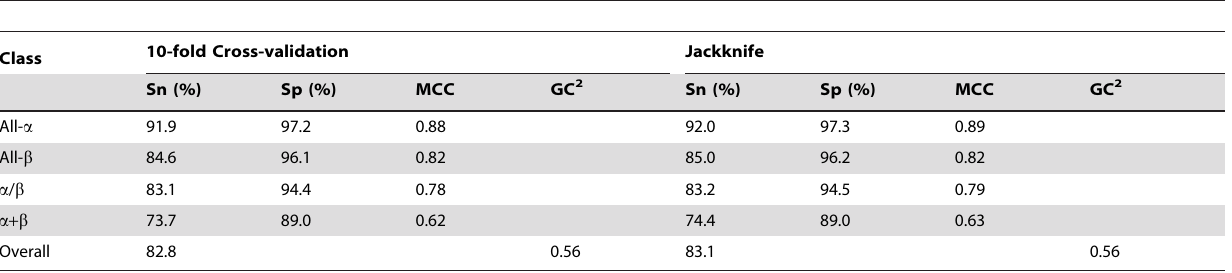
Table 1. Performance of the 10-fold cross-validation and jackknife tests using the D8244 dataset.